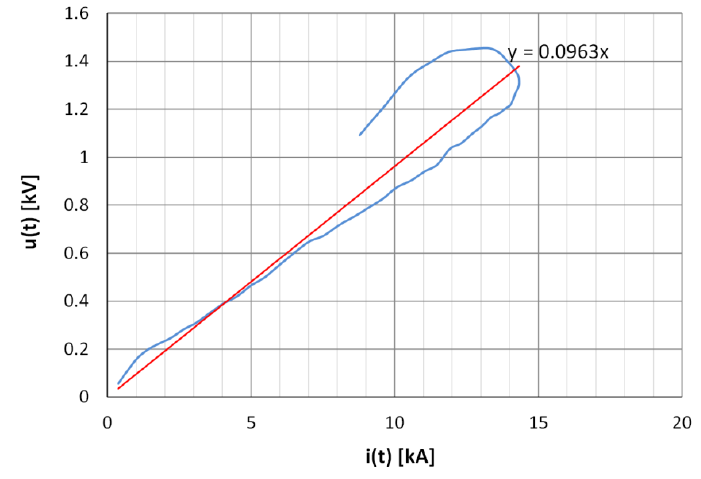
Figure 9. Voltage-current characteristic of the CFRP1 sample for the test with the first impulse (in blue) with added trend line (in red).